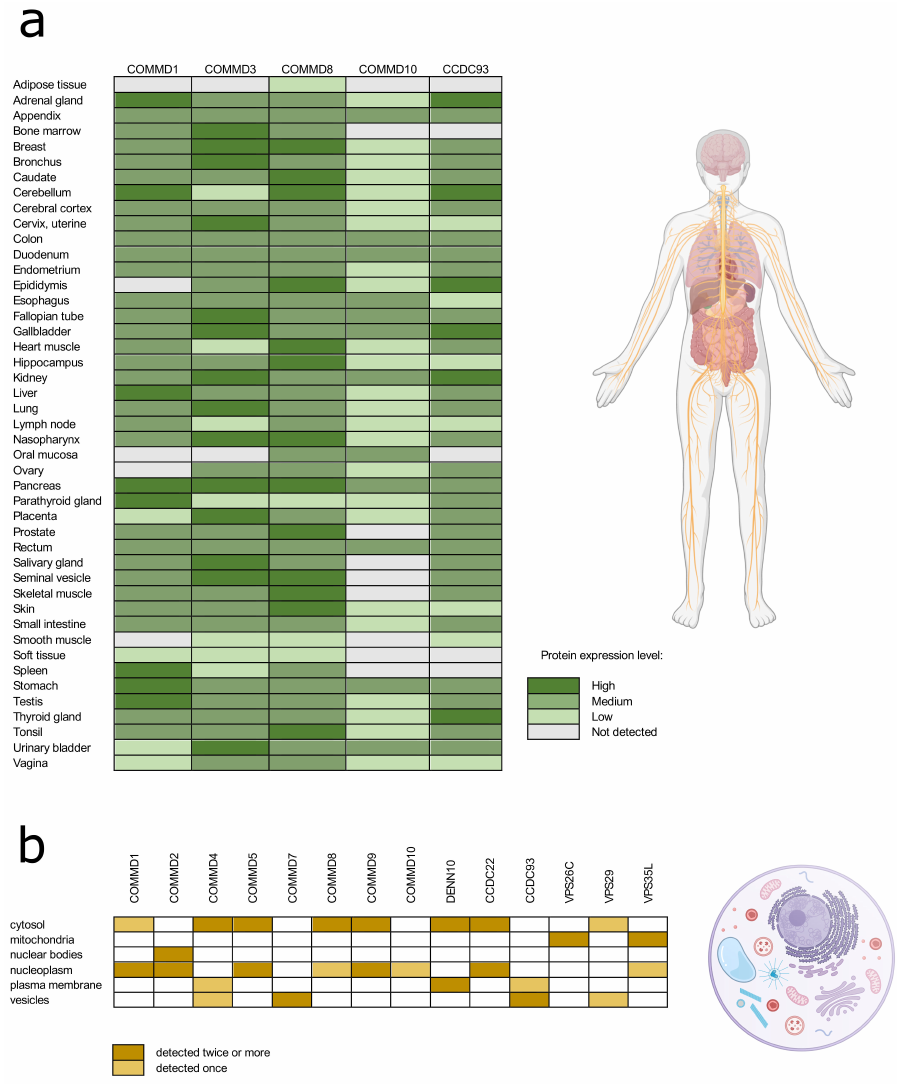
Figure 2. The protein expression in different tissue types ( a ) and intracellular location ( b ) of the commander complex proteins according to the Human Tissue Atlas database. Data with reliability score less than approved were excluded from the